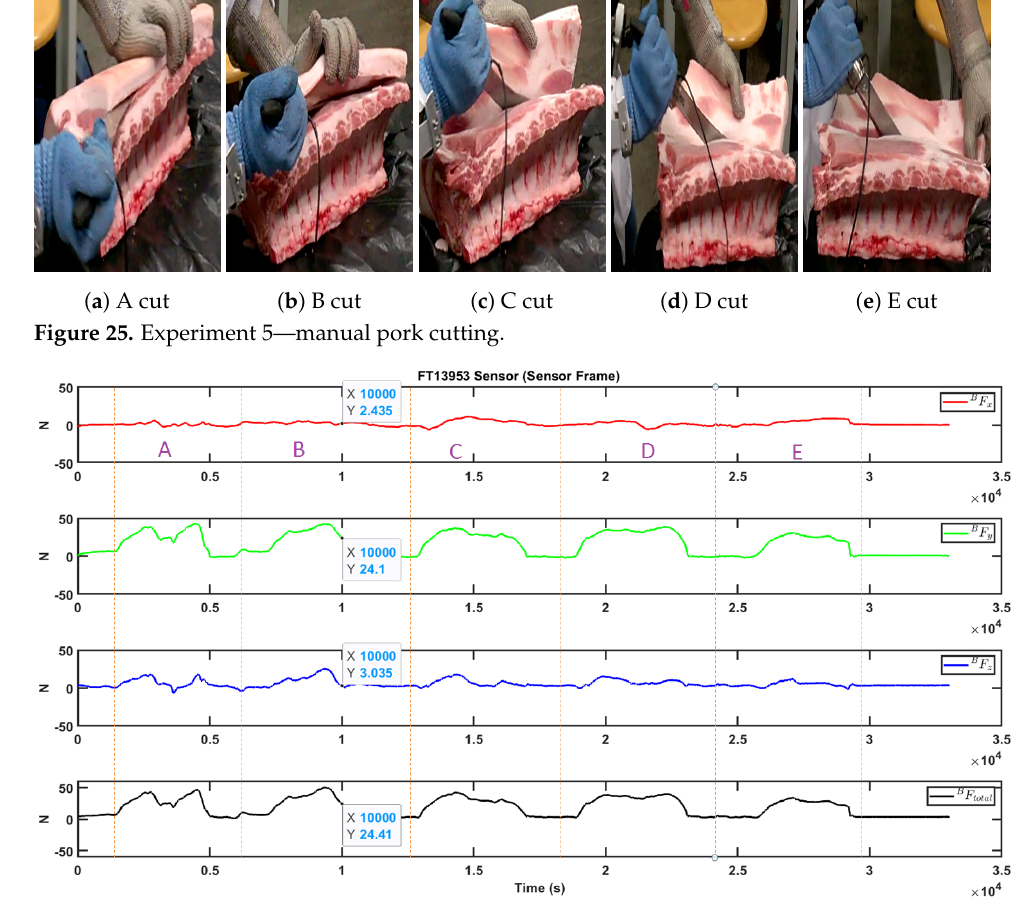
Figure 26. Forces applied by the user in Experiment